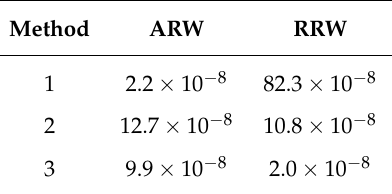
Table 2. Estimated values of ARW and RRW spectral densities for virtual gyros obtained from experimental data by three different methods. Method 1 is the unweighted average of the gyro signals. Method 2 uses only the diagonal elements of ˆ Q to calculate the coefficients. Method 3 is the optimal linear combination, which is calculated using the entire ˆ Q